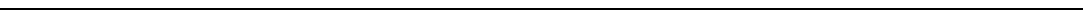
Fig. 1 Effect of number and timing of antibiotic doses on intestinal microbial communities. a Study design: 5-day-old C57BL/6 pups were treated with one course of tylosin at P5 for 5 days (PAT1 group) through their mother ’ s milk, or with two additional doses at P27 and P36 for 3 days each (PAT3 group). Twelve-week-old dams were treated with one course at pup P5. Sample sizes for dams were n = 7 (PAT), n = 3 (control). Sample sizes for their pups were n = 12 (control), n = 17 (PAT1), n = 19 (PAT3). b Mean ( ± SEM) unrari fi ed α -diversity using the phylogenetic diversity (PD) metric in fecal samples of dams and offspring (pups) over the course of the experiment. Solid lines represent female pups n = 3 (control), n = 8 (PAT1), n = 9 (PAT3) and dams; dotted lines are male pups; n = 9 (control), n = 9 (PAT1), n = 10 (PAT3). Statistical analysis performed using two-sample t -test with Monte Carlo permutations, for statistical signi fi cance, see Supplementary Table 1. c Unweighted UniFrac analysis of fecal specimens of pups and dams visualized by principal coordinate analysis (PCoA). The three components explain 42.3% of the total variance. d Intergroup unweighted UniFrac distances averaged over independently drawn sample pairs (subsampled without replacement and replicated 999 times) for the time points and groups shown in ( c ) shading indicates initial period of antibiotic exposure (for statistical signi fi cance, see Supplementary Table 2). e Mean relative abundance of taxa in control, PAT1 and PAT3